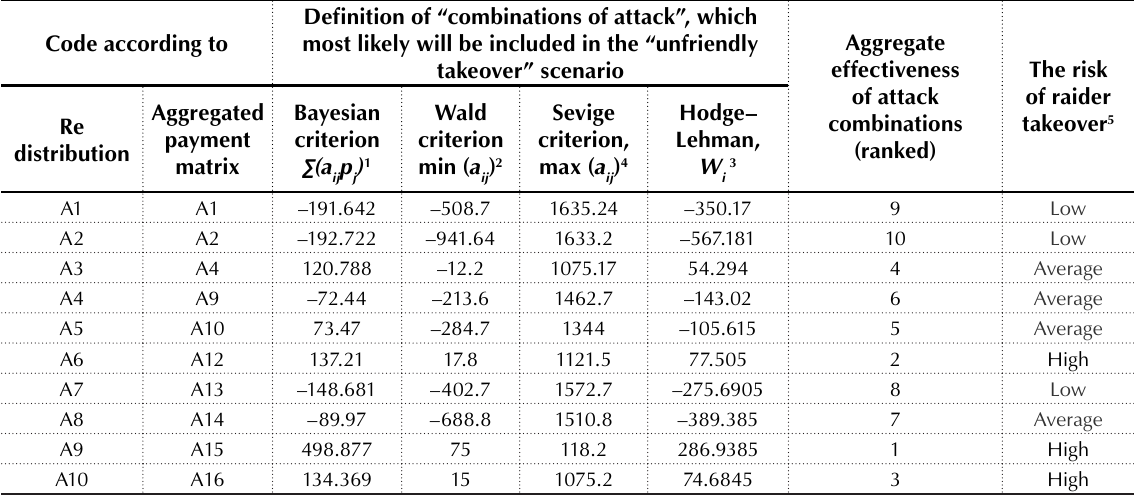
Table 3. The results of the estimation of the attack combinations of LLC “TENT TRANS” according to the probability of use during hostile takeover, thousand UAH Source: Calculated by author based on Bartish and Dudzyaniy (2009). Code according